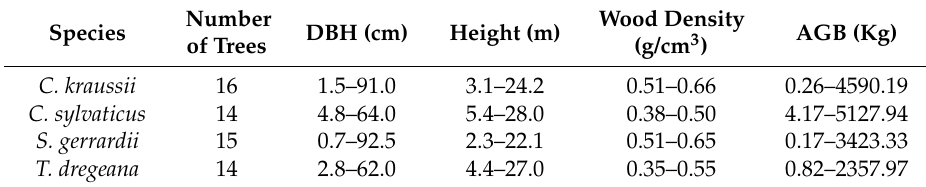
Table 1. Descriptive summary (minimum and maximum values) of characteristics of measured tree